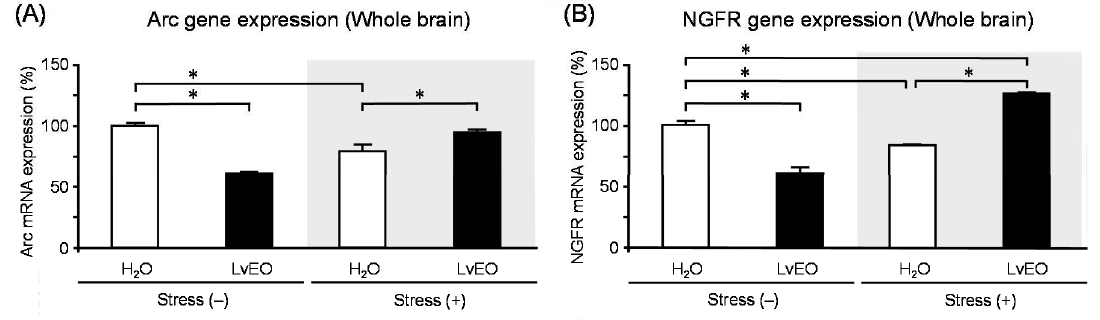
Figure 3. The effects of lavender on gene expression levels in the mouse brain. RT-PCR analysis was performed using the whole brain of mice inhaled with distilled water or lavender essential oil (LvEO) after water immersion stress. ( A ): Expression of Arc gene. ( B ): Expression of nerve growth factor receptor (NGFR) gene. The results are expressed as the ratio of the mRNA expression level to that of glyceraldehyde-3-phosphate dehydrogenase (GAPDH) (%), and are means ± SEM (n = 4). * p < 0.05 (Tukey–Kramer’s HSD test). This figure is modified based on the original figure published [90].